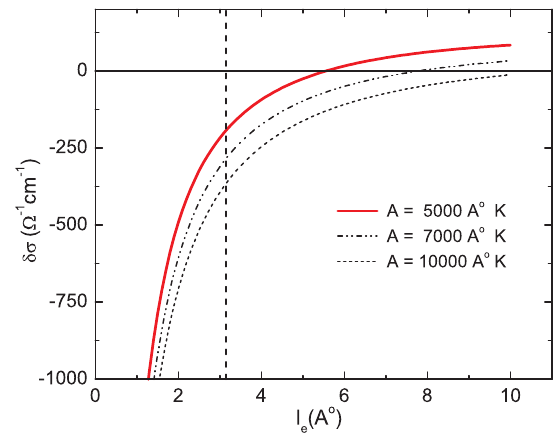
Figure 5. Weak localization correction δσ (3D) to the Boltzmann conductivity (in accordance with Equation(3)) as a function of the mean free electron path between elastic collisions l e . For the estimate at T =300K, the mean free electron path between inelastic collisions l ϕ = AT − P , P =1 [5]. The estimate is given for different values of the parameter A